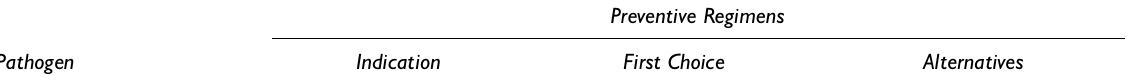
Table 3 Prophylaxis to prevent recurrence of opportunistic disease in adults (after chemotherapy for acute disease) in adults and adolescents infected with human immunodeficiency